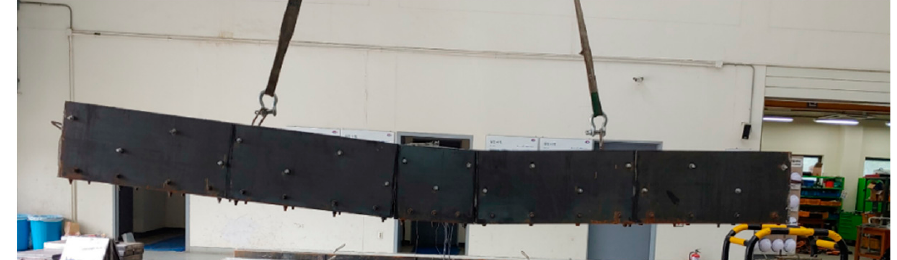
Figure 11. The shape of the test specimen after a flexural test.